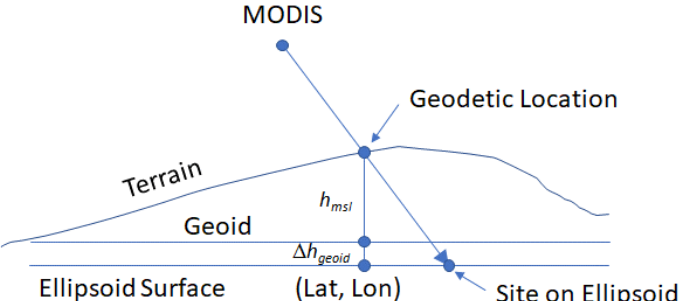
Figure 2. MODIS pixel geographic coordinates represent the geodetic location where the line-of-sight pierces the terrain surface. We recalculate the geographic coordinates to represent where the line-of-sight pierces the WGS-84 ellipsoid considering the terrain height above the geoid (i.e., mean sea level) and the height of the geoid above the ellipsoid (gravity model).